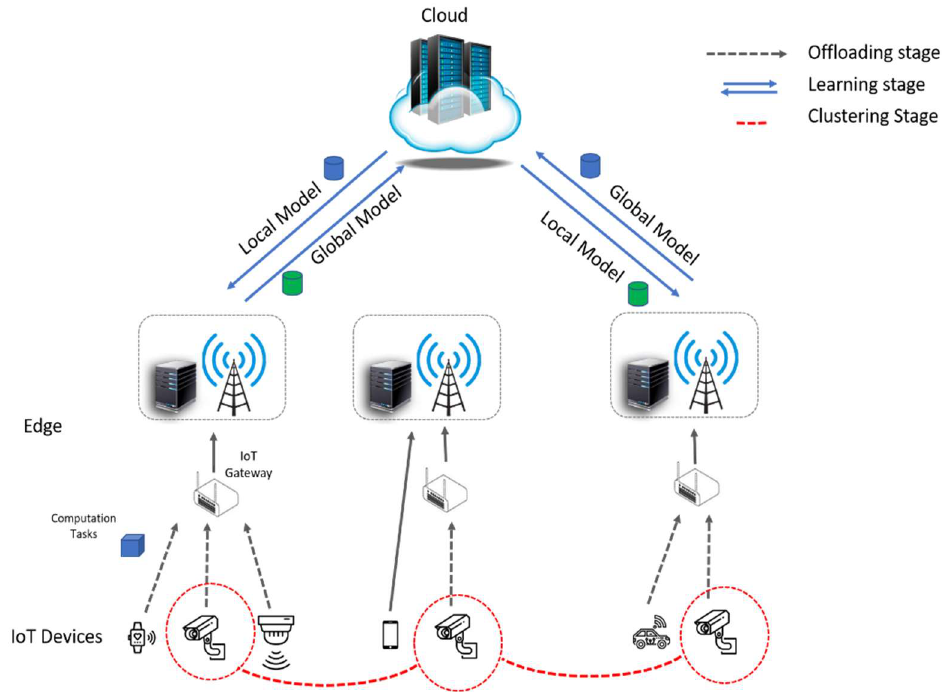
Figure 3. The multitask federated learning framework for intelligent IoT applications.